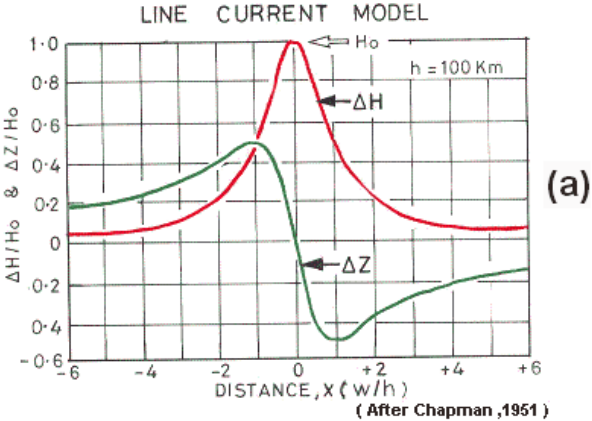
Fig. 2a. The variation of the horizontal (H) and vertical (Z) mag- netic field components at ground due to an infinite straight horizon- tal electric current flowing at a height h above the plane Earth; the ordinates represent fraction of Ho, the surface field directly below the current, the abscissa are expressed an terms of “h” as unit.